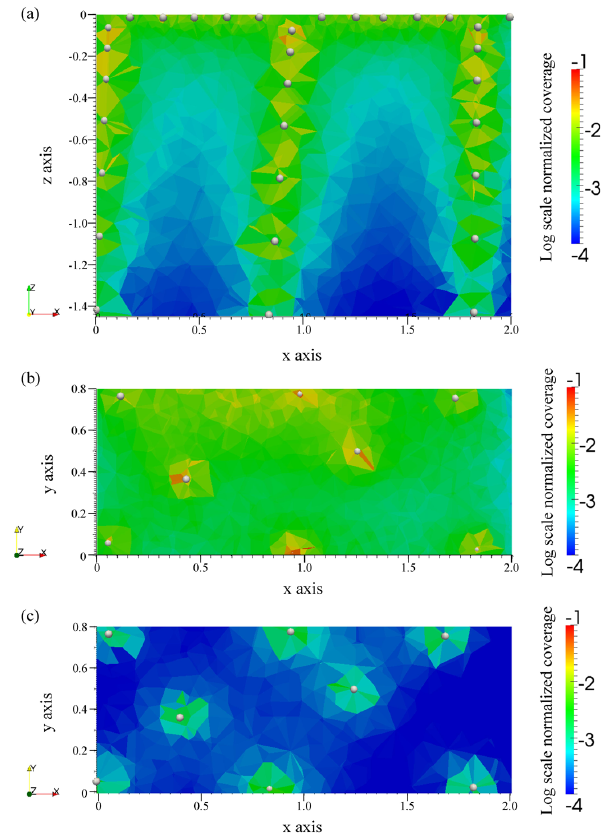
Fig. 9. Normalized coverage sections at y = 0 . 05m (a) , z = − 0 . 15m (b) , and z = − 1 . 4m (c) of the 3-D ERT inversion model. The coverage was calculated using Eq. (7). The white spheres rep- resent the electrodes in the considered